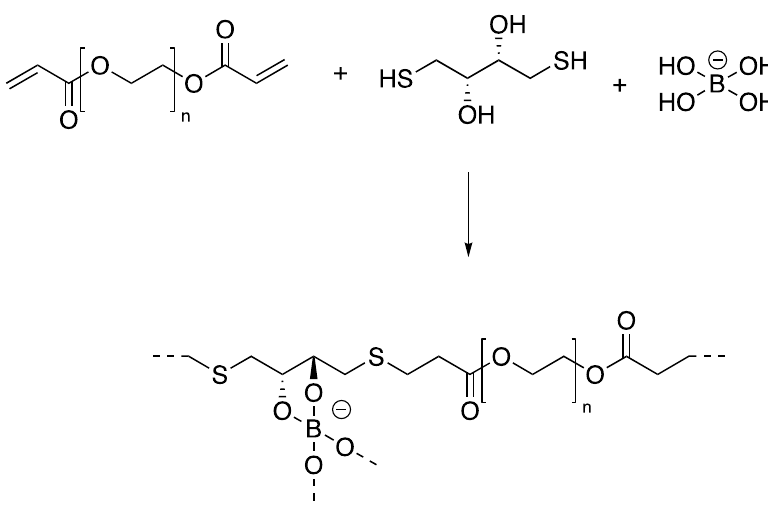
Figure 8. Hydrogels based on poly(ethylene-glycol) (PEG) with the use of thiol-ene addition and a borax-diol chemistry. Adapted and re-drawn from [35].